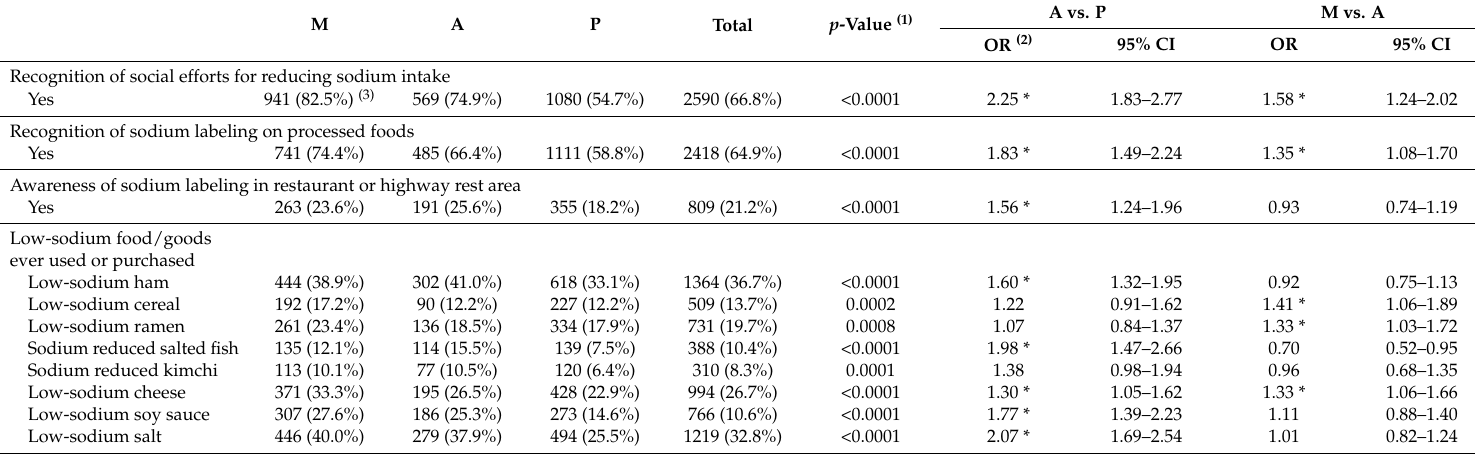
Table 2. Recognition of supportive environment and purchasing experience of reduced sodium